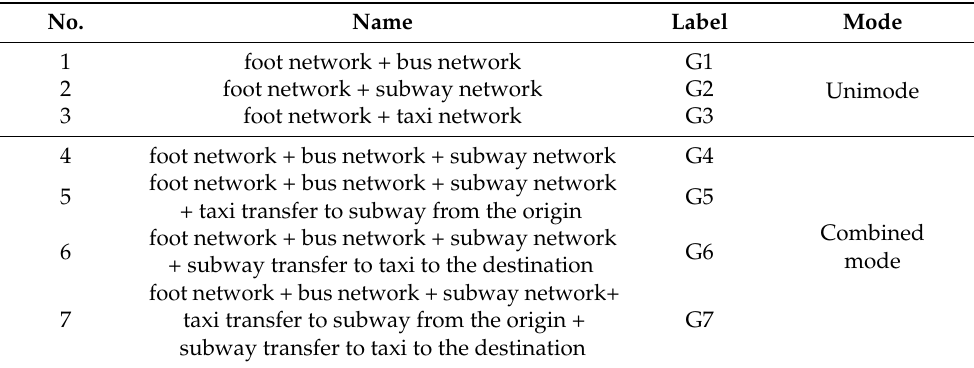
Table 2. Network